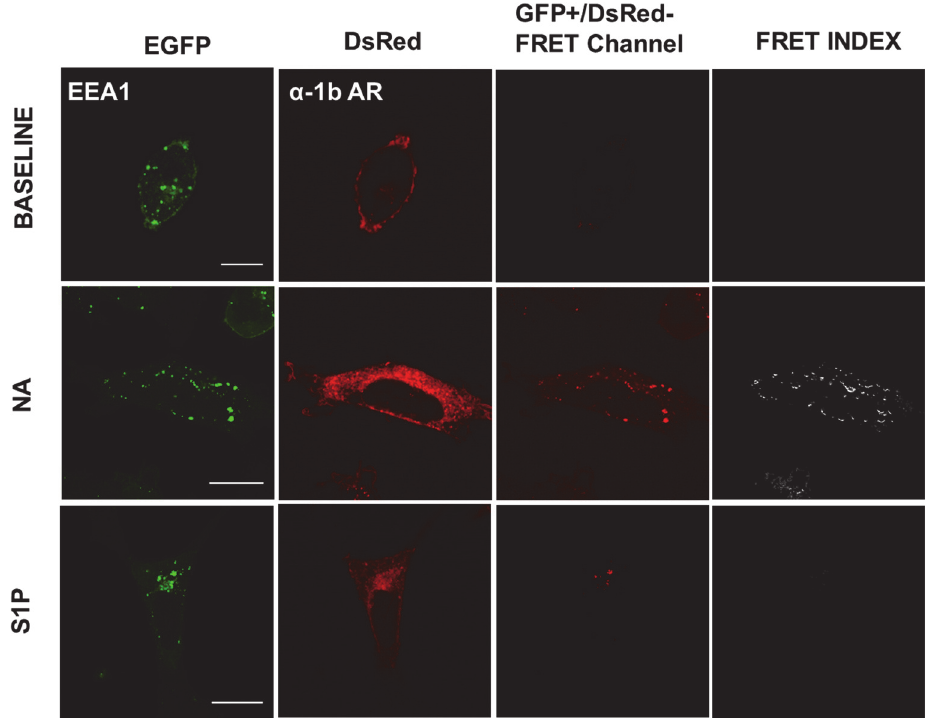
Fig 4. α 1B -Adrenergic receptor-early endosome antigen 1 interaction. Images of cells coexpressing α 1B - adrenergic receptors tagged with the DsRed fluorescent protein ( α 1B -AR) and the early endosomes antigen 1 (EEA1) tagged with the enhanced green fluorescent protein (EGFP). Cells were incubated for 15 min in the absence of any agent (B, upper row) or presence of 10 μ M noradrenaline (plus 1 μ M propranolol) (NA, middle row) or 1 μ M sphingosine 1-phosphate (S1P, lower row). Cells were fixed and observed in a fluorescence confocal microscope. The following images are presented: EGFP fluorescence (EGFP was excited and its fluorescence recorded; first column), DsRed fluorescence (DsRed was excited and its fluorescence recorded; second column), “ FRET channel ” (EGFP was excited, the laser to excite DsRed remained off, and DsRed fluorescence was recorded; third column) and “ FRET index ” (images processed with the "FRET and Colocalization Analizer", fourth column). Scale bars: 15 μ m. indexes for the EEA1 and wild-type Rab proteins images is presented in Fig. 9 (panel A, nor- adrenaline (NA); panel B, sphingosine 1-phosphate (S1P)).